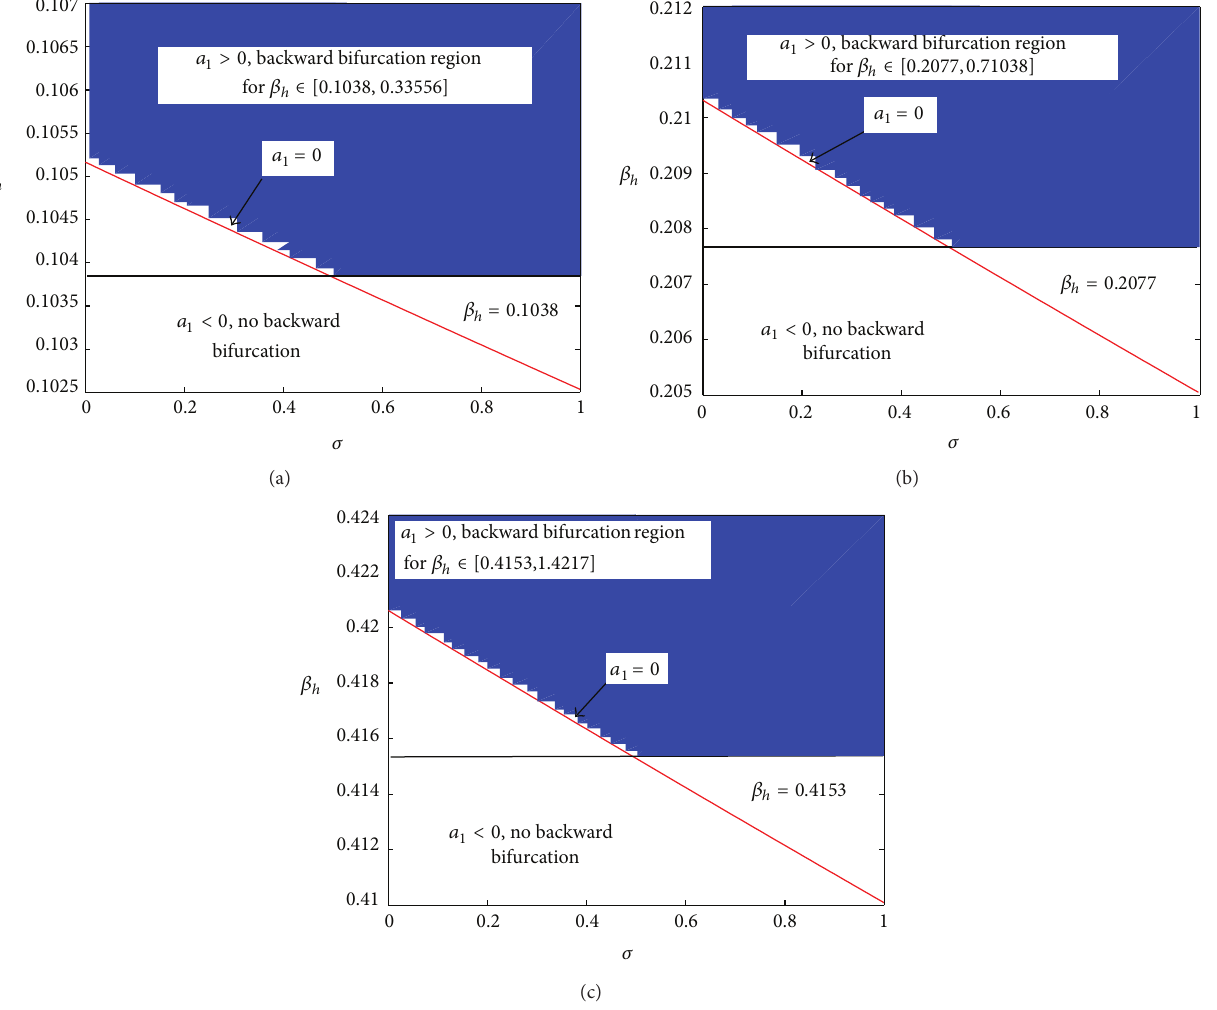
𝛽 ∈ [0.1038, 0.35556]) , (b) 𝜇 = 0.1, ℜ = 0.00035113 (backward bifurcation region for 𝛽 ℎ is ℎ 𝑣 0